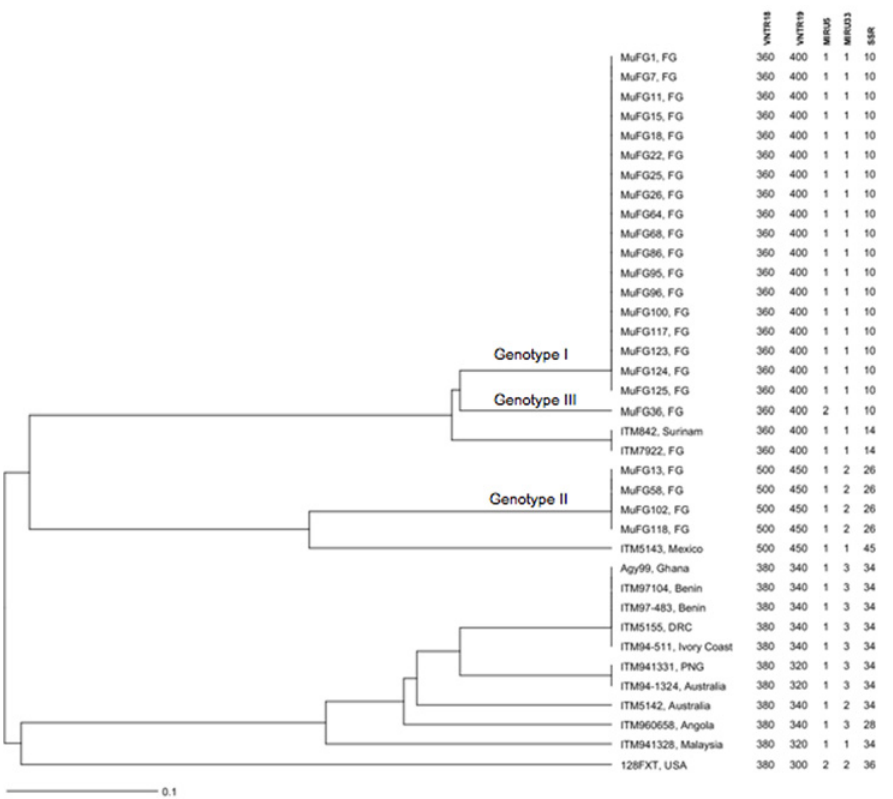
Fig 2. UPGMA phylogenetic tree. The analysis is based on amplicons size of VNTR18 and VNTR19 makers, and tandem repeats number for MIRU5, MIRU33 and SSR; FG, French Guiana; DRC, Democratic Republic of Congo; PNG, Papua New Guinea.